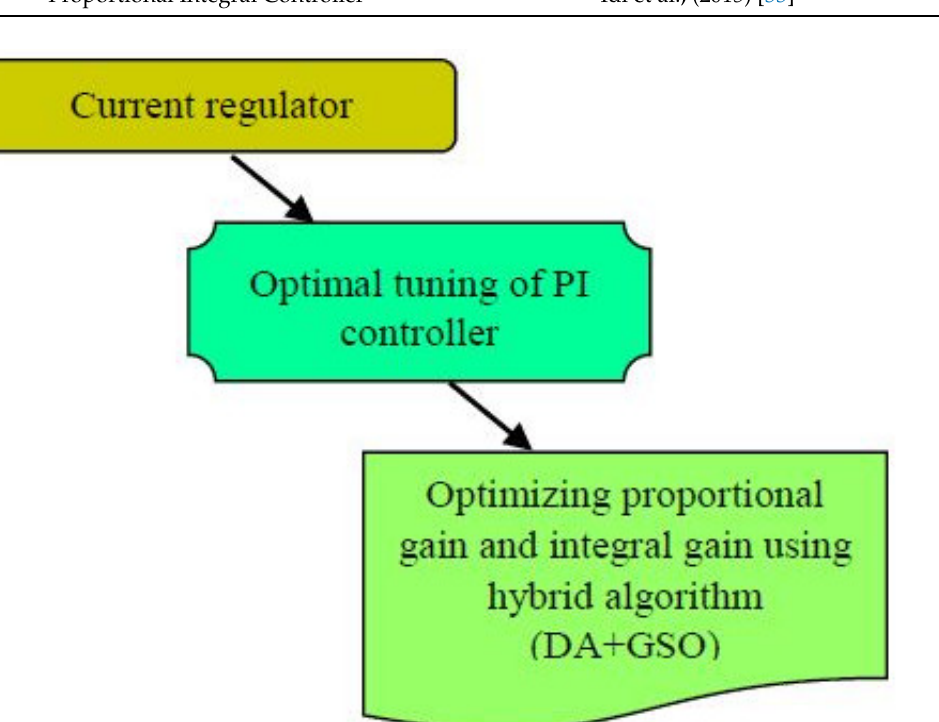
Figure 1. Proposed efficiency optimization model of induction motors.